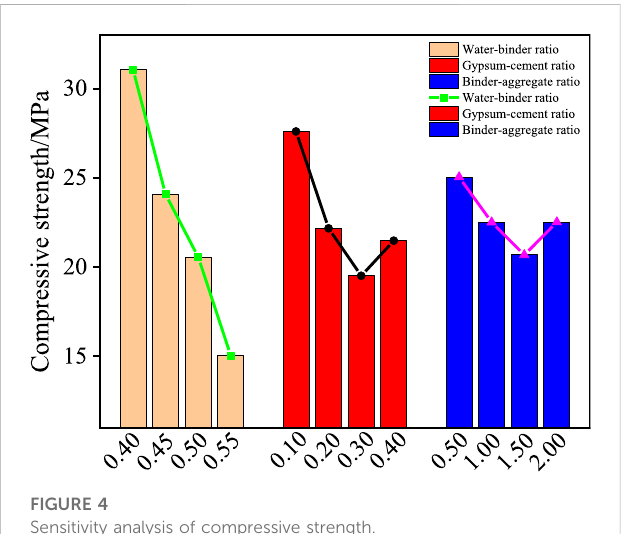
FIGURE 4 Sensitivity analysis of compressive strength.